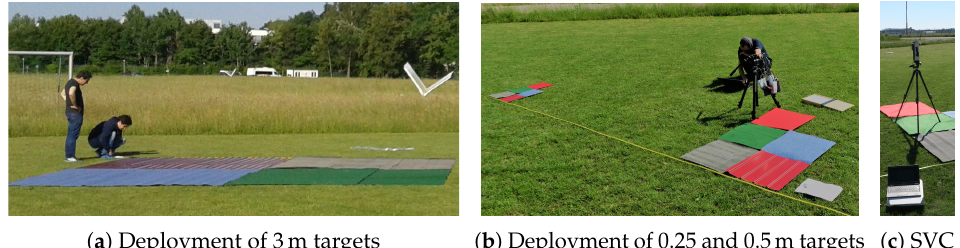
Figure 2. Impressions from the field work during the DLR HySU benchmark campaign. The deployment of the large 3m targets and the small 0.25 and 0.5m targets is shown in ( a , b ), respectively. The typical measurement setup of the SVC field spectrometer can be seen in ( c